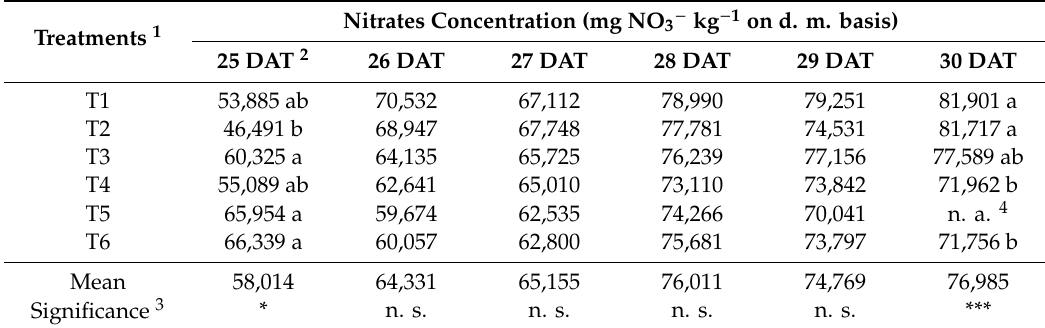
Table 9. Autumn trial: nitrate concentration in lettuce on dry matter basis. Treatments